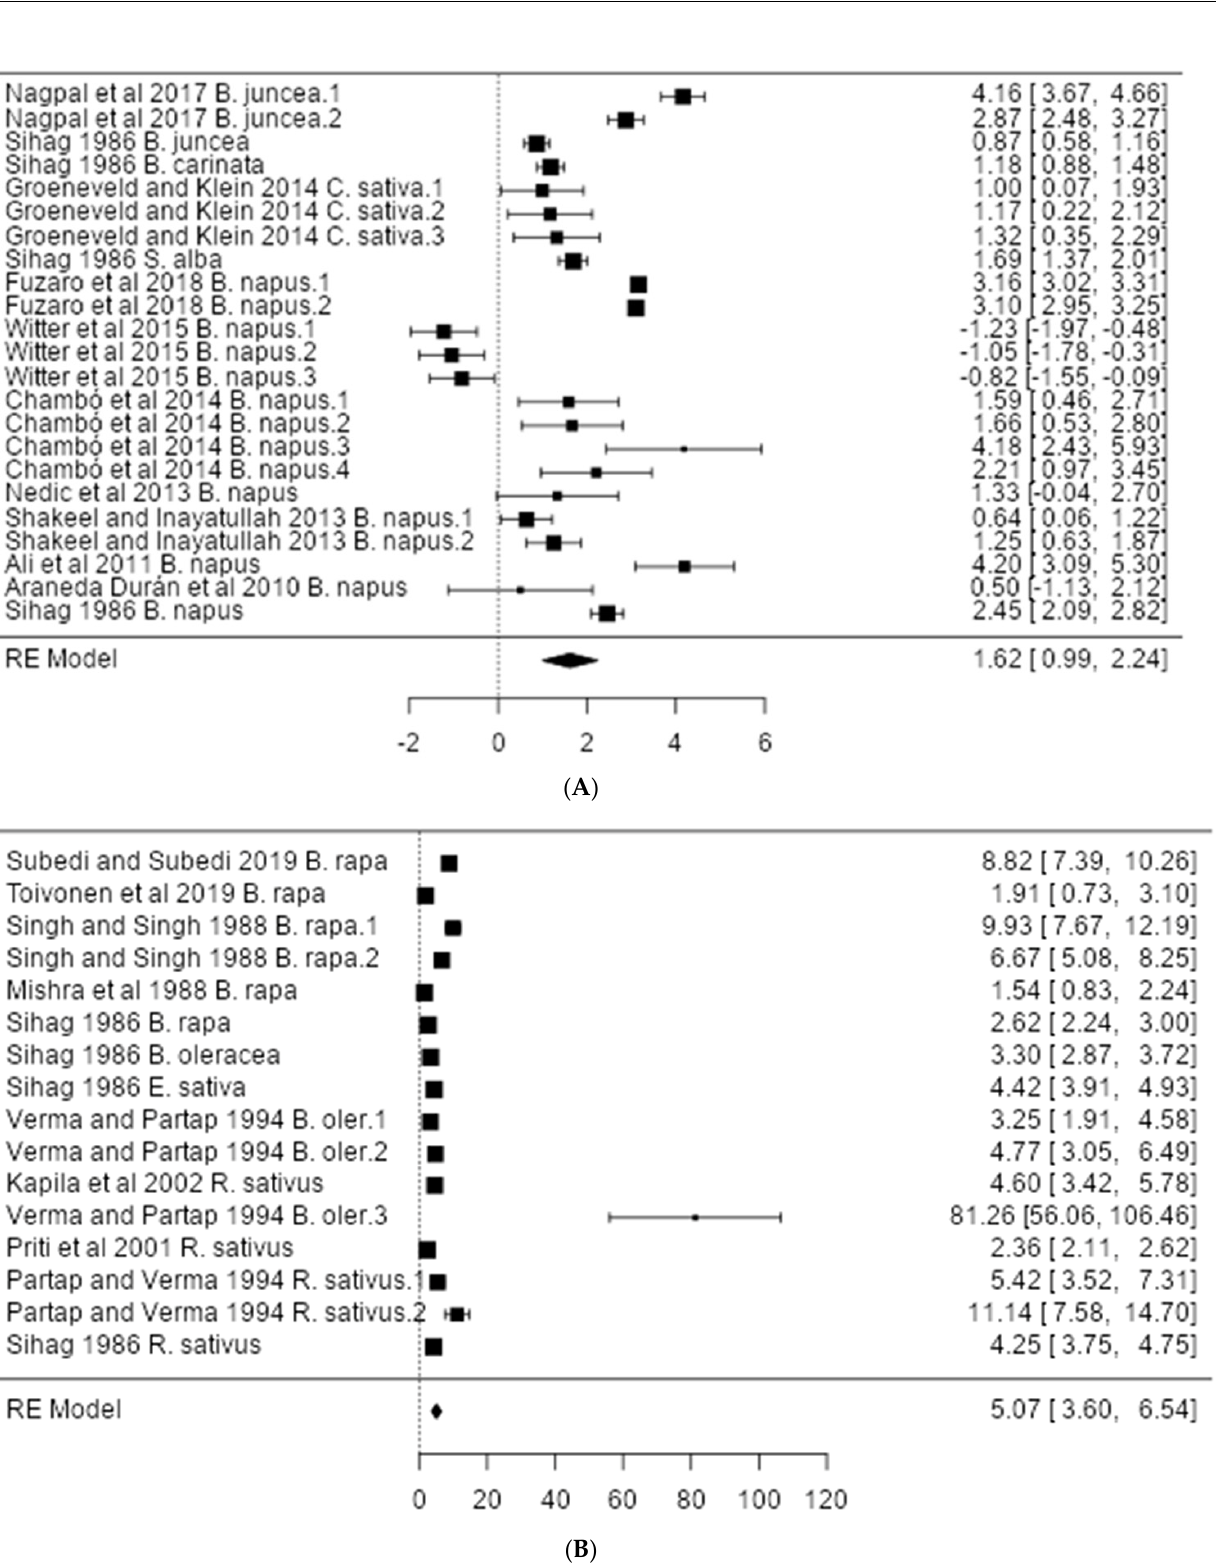
Figure 7. Forest plot of the meta-analysis for the effect of insect pollination on the number of seeds per silique in self-compatible ( A ) and self-incompatible Brassicaceae crops ( B ). In some cases, B. oleracea has been abbreviated to B. oler. to prevent overlapping with error bars and squares.